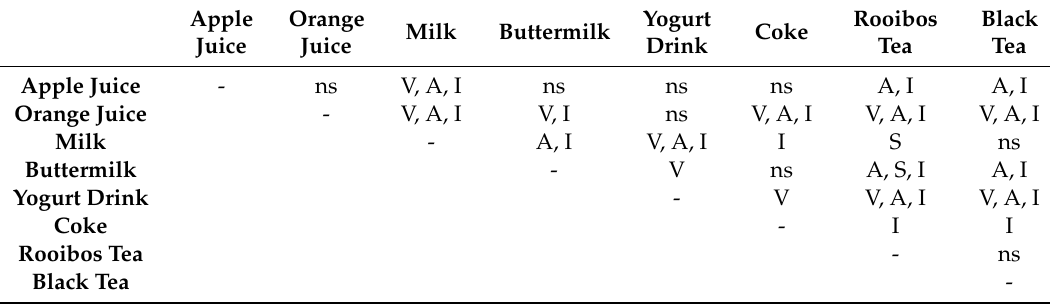
Table 3. Combinations of regular drinks that were significantly di ff erent ( p < 0.05) according the post-hoc tests in terms of valence (“V”), arousal (“A”), sip size (“S”), and IBI (“I”). Examples of no significant di ff erences for any of the four measures is indicated with